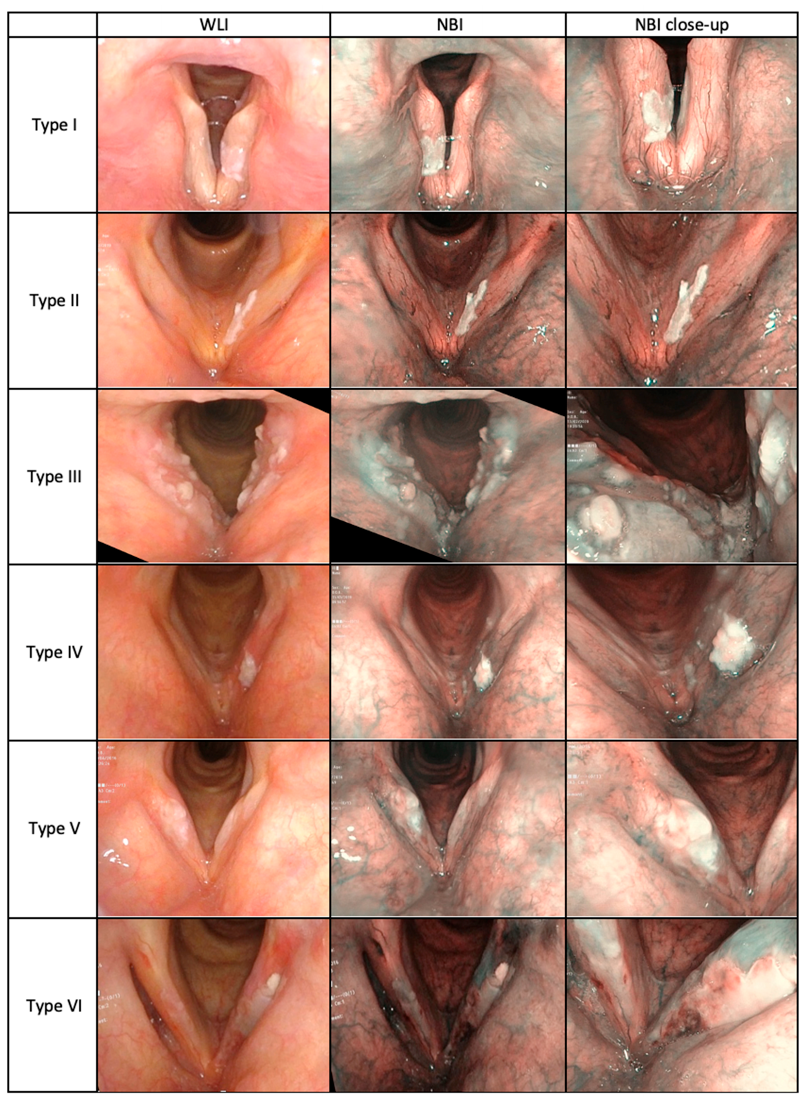
Figure 1. Narrow Band Imaging classification, according to Ni et al. 2019, based on the authors’ repository images from patients with vocal fold leukoplakia ( n = 296) who were enrolled in the study.